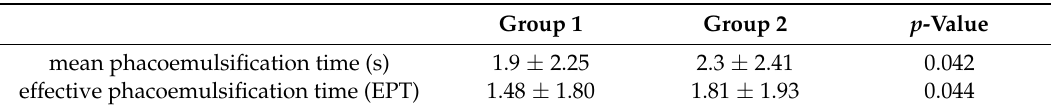
Table 1. Mean phacoemulsification time/effective phacoemulsification time for Groups 1 and 2.